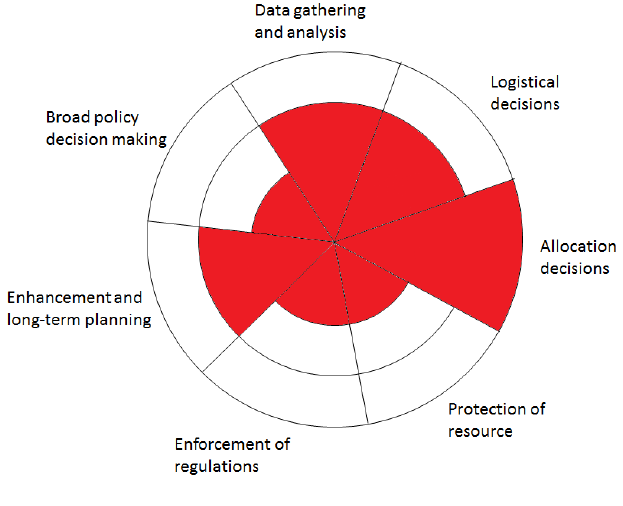
Fig. 5 . The relative contribution of the Lincoln Water Transfer Limited scheme to Pinkerton’s seven comanagement